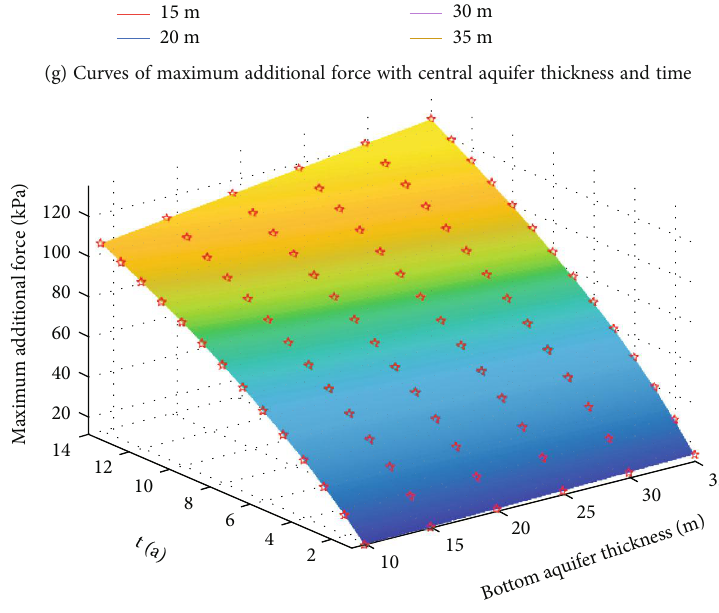
Figure 16: Relationship between the additional force and central aquifer